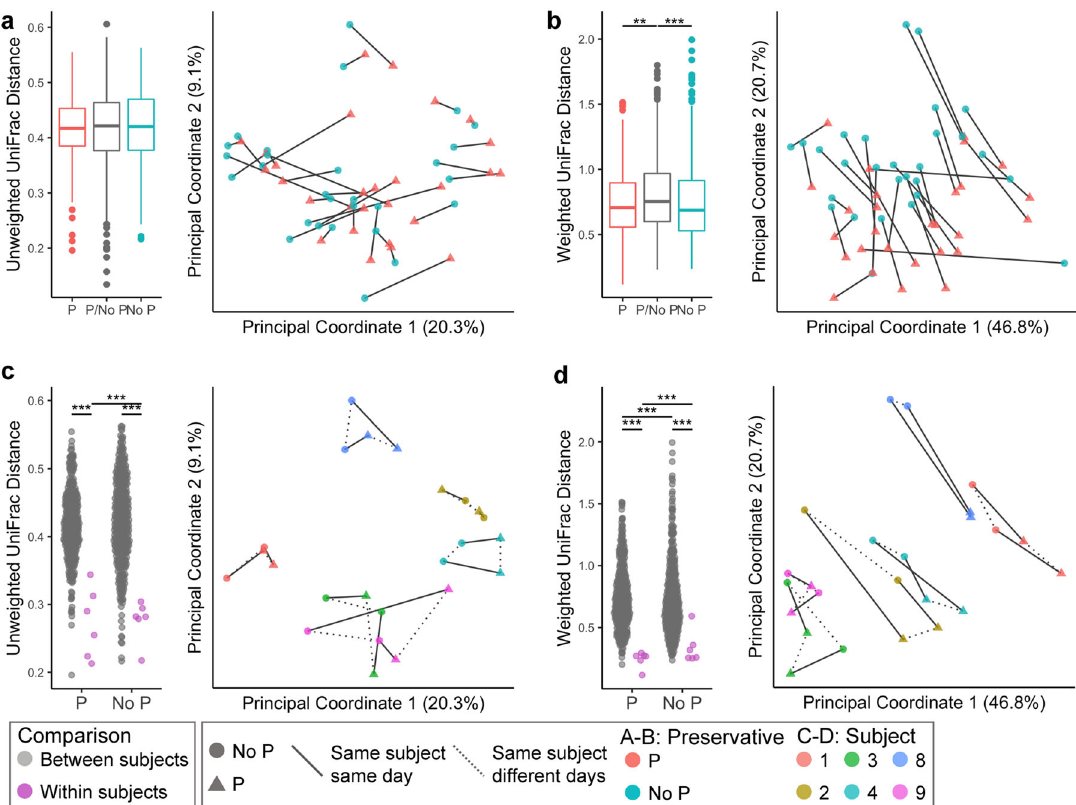
Fig. 3 Phylogenetic beta diversity for 16S rRNA gene analyses of saliva samples by collection method and across time. Top panels: unweighted ( a ) and weighted ( b ) UniFrac distance of all samples according to the collection method. Left panels: median (and IQR) distances in within-sample comparisons: preservative samples only (P), non-preservative samples (No P), and across sample sample collection methods — preservative vs non-preservative samples (P/No P). Right panels: PCoA plots of all samples by the sample collection method. Bottom panels: unweighted ( c ) and weighted ( d ) UniFrac distances of the paired specimens from six subjects sampled on two consecutive days and according to collection method. Left panels: distance between unrelated subjects (gray) or within an individual across days (pink) separated by collection method: preservative samples (P) and non-preservative samples (no P). Right panels: PcoA plot of all samples with only six multi-day subjects visualized. For all left panels, pairwise Wilcox test with FDR correction ** q < 0.01, *** q < 0.001. Lines connect specimens collected from the same subject on the same day (solid) or different days